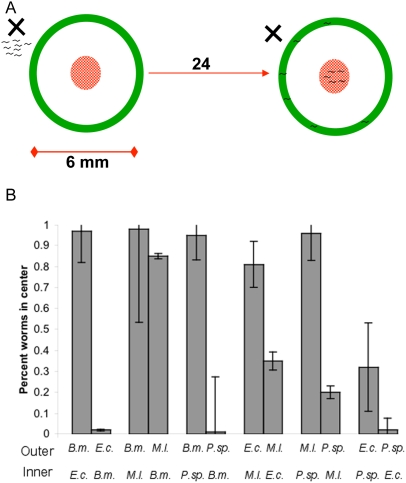
Food preference.(A) Food preferences of wild-type animals were measured in a biased choice assay modified from Shtonda and Avery (2006). Bacteria were arrayed on an agar plate as shown. Synchronized L1 larvae were placed outside the outer circle (indicated by the X) and the fraction in the center bacterial type was determined after 24 hours. (B) Fraction of nematodes in the center bacterial type is shown for all pair-wise comparisons, and reciprocal comparisons were used for C. elegans food preference. Standard error for each mean is indicated with error bars. The bacteria listed under each bar were compared and are either outer (outer ring) or inner (inner circle) and B.m. = B. megaterium, M.l. = M. luteus, E.c. = E. coli, P.sp. = Pseudomonas sp.